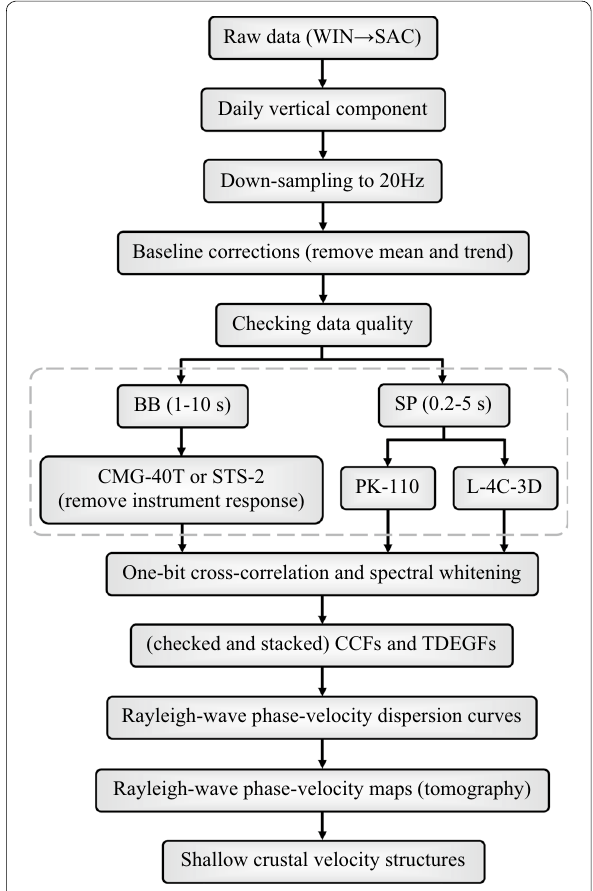
Fig. 2 Data processing of ambient seismic noise